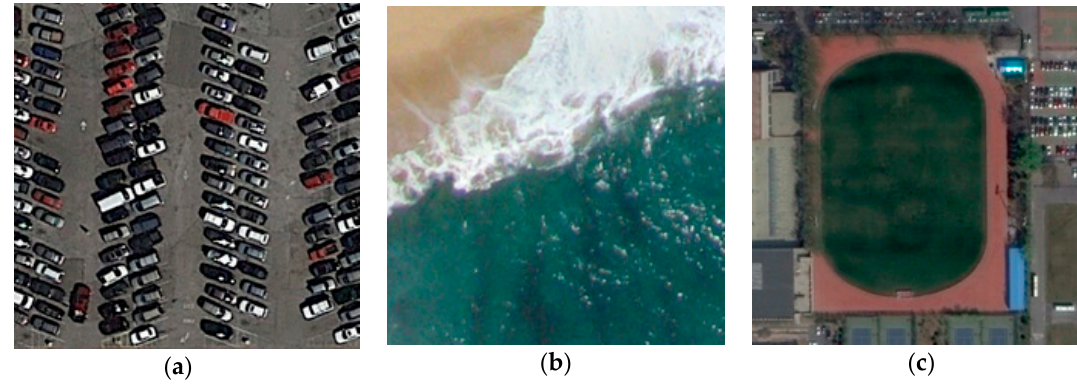
Figure 10. Some results using the attention-based method [21] and SM-Att+LSTM. ( a ) Attention [21]: many cars are parked in a parking lot near several green trees . SM-Att+LSTM: many cars are parked in a parking lot. ( b ) Attention [21]: yellow beach is near a piece of green ocean. SM-Att+LSTM: yellow beach is near a piece of green ocean with white wave. ( c ) Attention [21]: some buildings and green trees are around a playground. SM-Att+LSTM: a playground is surrounded by some green trees and buildings.